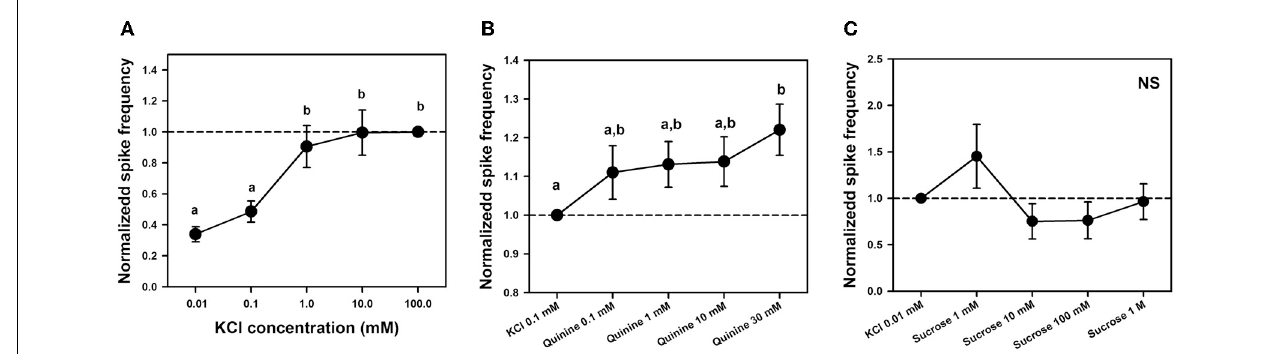
FIGURE 7 | (A) Experiment 4. Mean normalized spike frequencies ( ± SE) obtained upon stimulation with 5 different concentrations of KCl solution: 0.01, 0.1, 1, 10, and 100mM. Responses (action potentials per second) were normalized to those recorded for KCl 100mM (hatched horizontal line), which yielded maximal responsiveness. Data were obtained from 6 bees in which responses to the 5KCl concentrations were recorded 4 times in 6 different sensilla ( n = 120). Different letters above bars indicate significant differences ( p < 0 . 05). (B) Experiment 5. Mean normalized spike frequencies ( ± SE) obtained upon stimulation with KCl 0.1mM and 4 different concentrations of quinine solution including KCl 0.1mM as contact electrolyte: 0.1, 1, 10, and 30mM. Responses (action potentials per second) were normalized to those